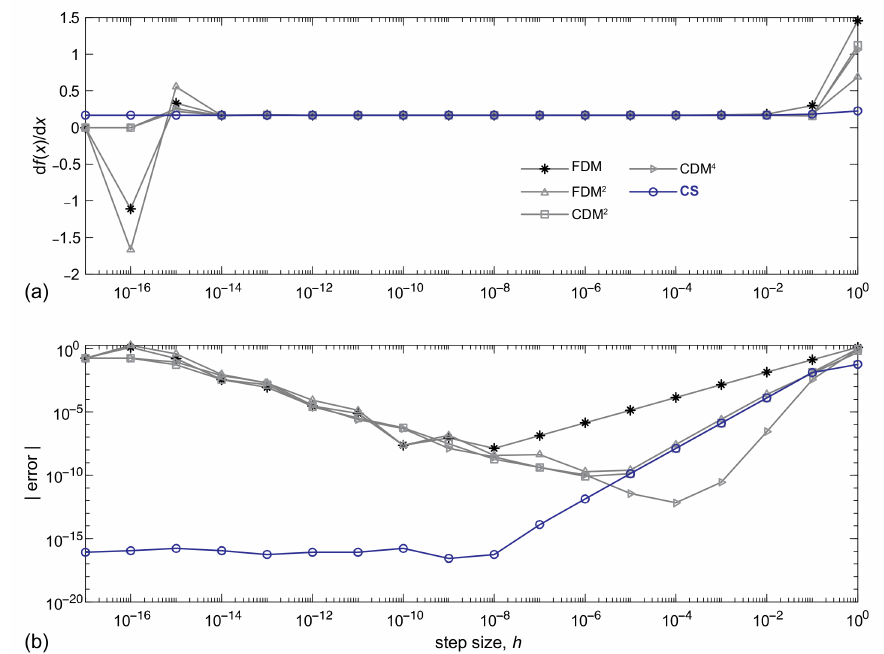
Figure 2. ( a ) Comparison of first derivatives by finite difference and complex-step (CS) methods, ( b ) absolute errors from computing the first derivatives with varying step